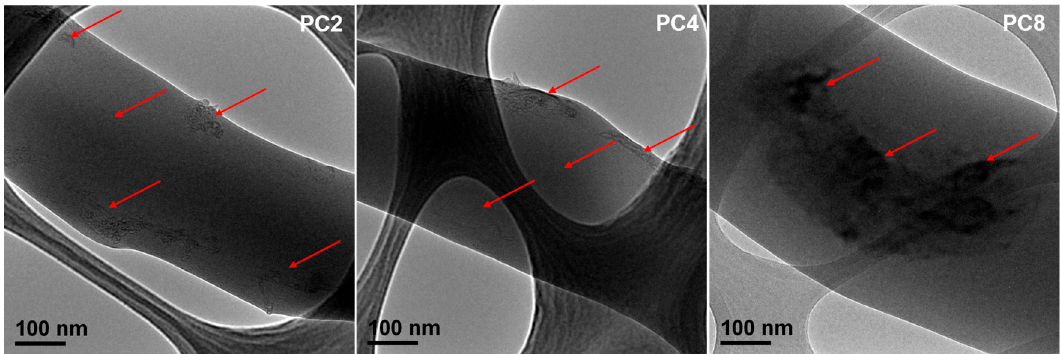
Figure 3. Selected TEM images of PC2, PC4 and PC8 electrospun nanofibers. Table 1. Average diameters, mechanical properties and water contact angles of scaffolds containing different MWCNTs-COOH content.